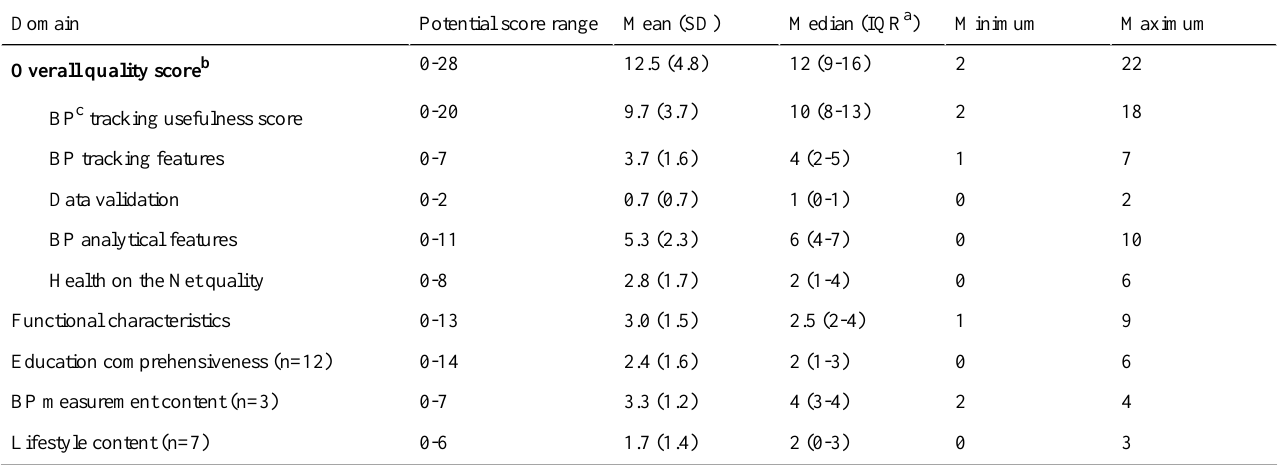
Table 2. Hypertension app scores for functionality, usefulness, and quality (n=62).